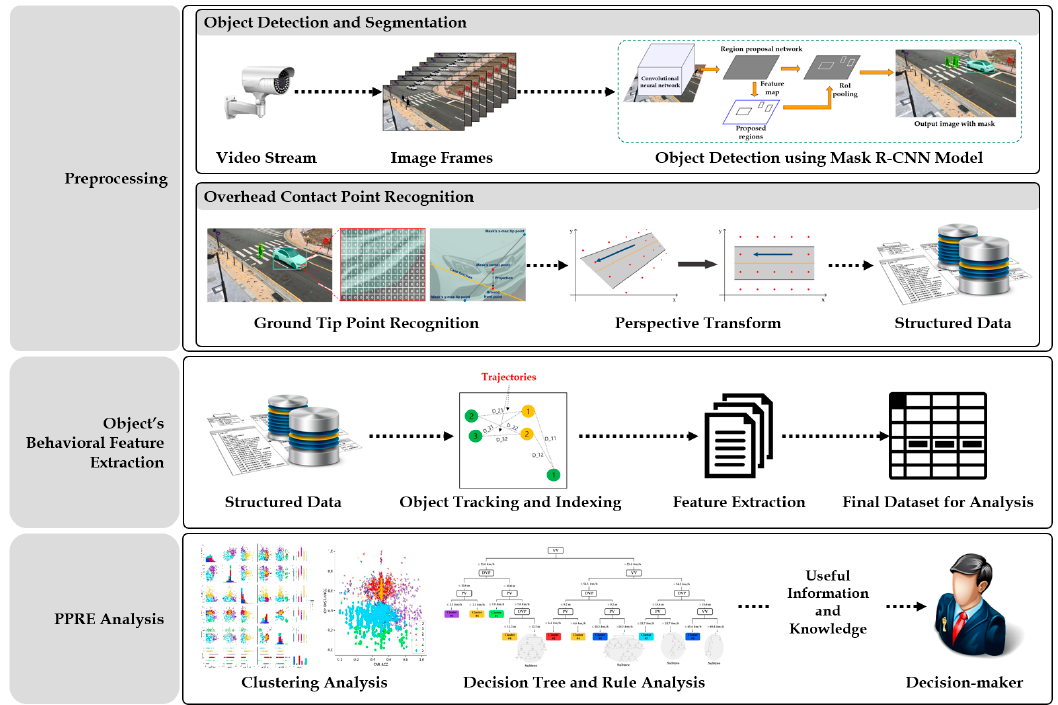
Figure 3. Overall architecture of the proposed analysis system.